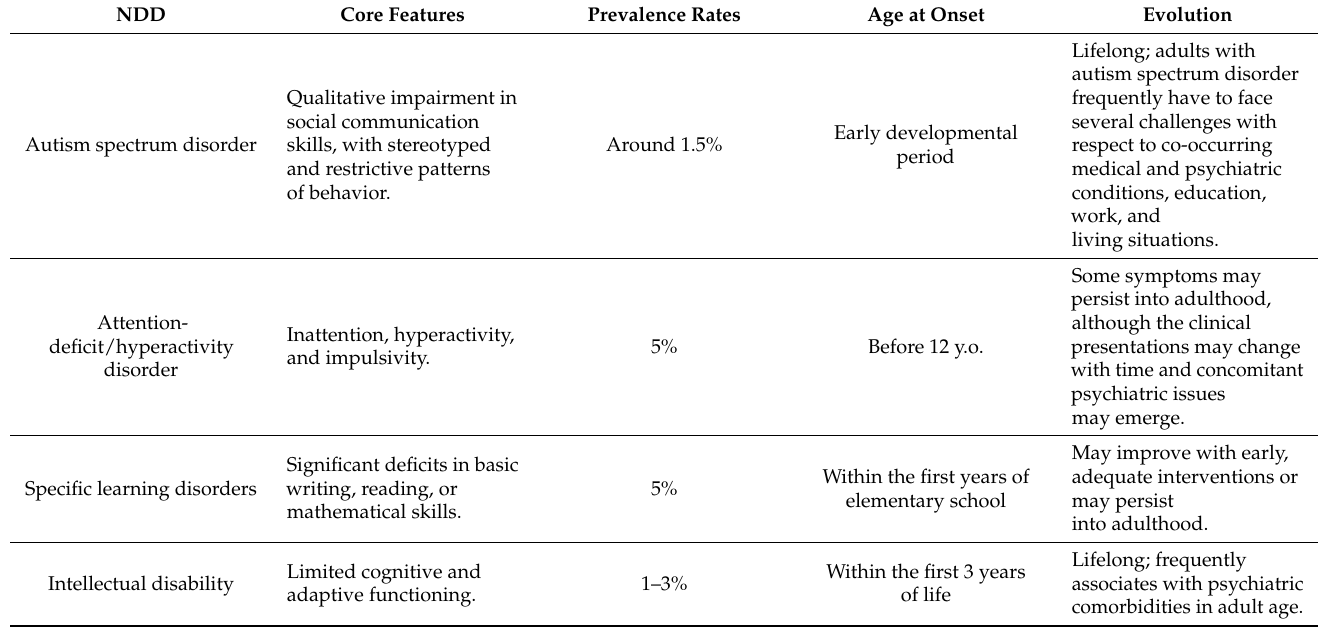
Table 1. Summary of core manifestations, prevalence rates, and life-course trajectory of the main neurodevelopmental disorders